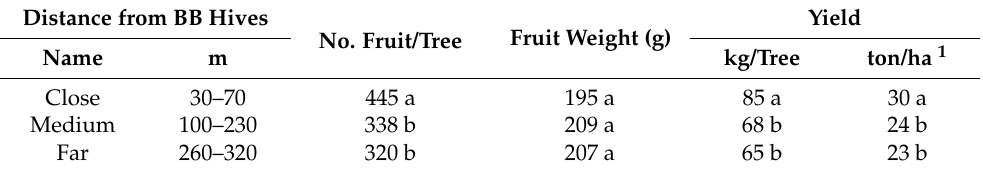
Table 5. Effect of adding bumblebee (BB) hives (April 2018) on the number of fruit per tree, fruit weight, and total yield (February 2019) at three distances from the BB hives, Regba, 2018/19. Distance from BB Hives Yield No. Fruit/Tree Fruit Weight (g) Name m kg/Tree ton/ha 1 Close 30–70 445 a 195 a 85 a 30 a Medium